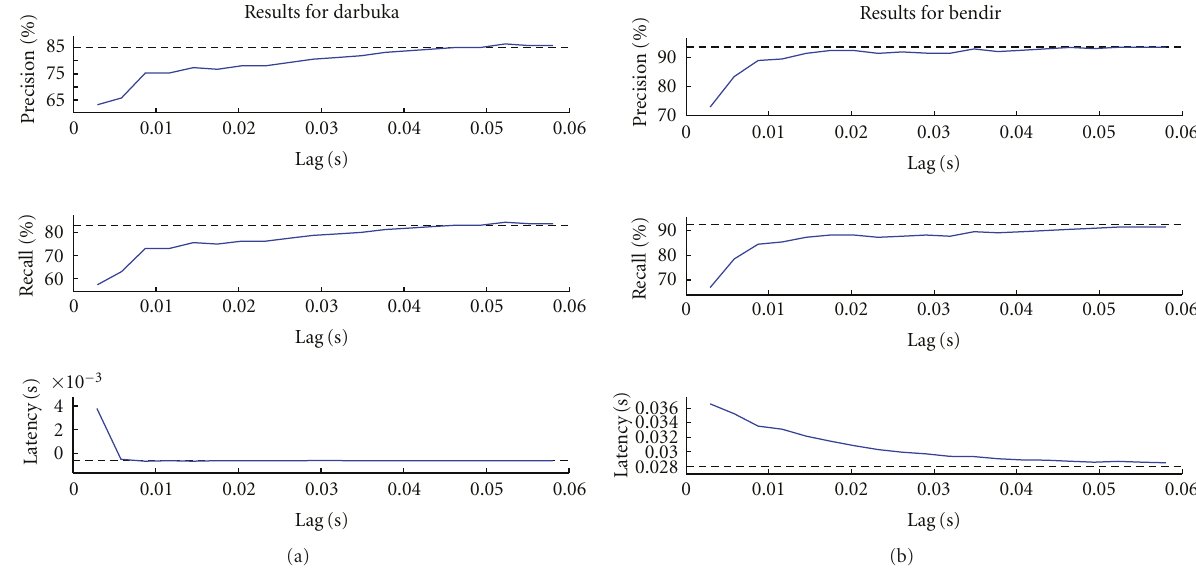
Figure 7: Comparison of algorithm performance between (a) darbuka and (b) bendir. The dashed line indicates o ffl ine